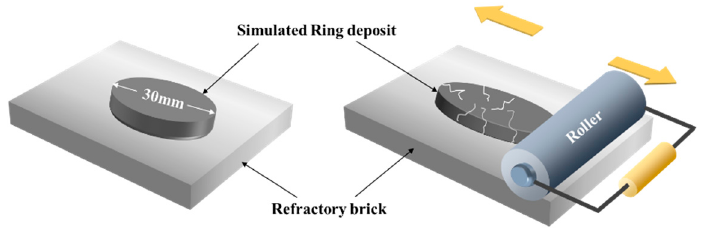
Figure 2. Schematic diagram for evaluating the adhesivity to refractory brick.